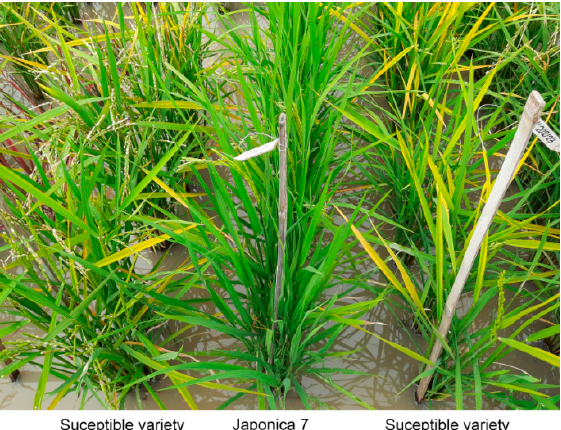
Figure 1. Field resistance to tungro disease of Japonica 7 in the 2020 wet season at IRRI.